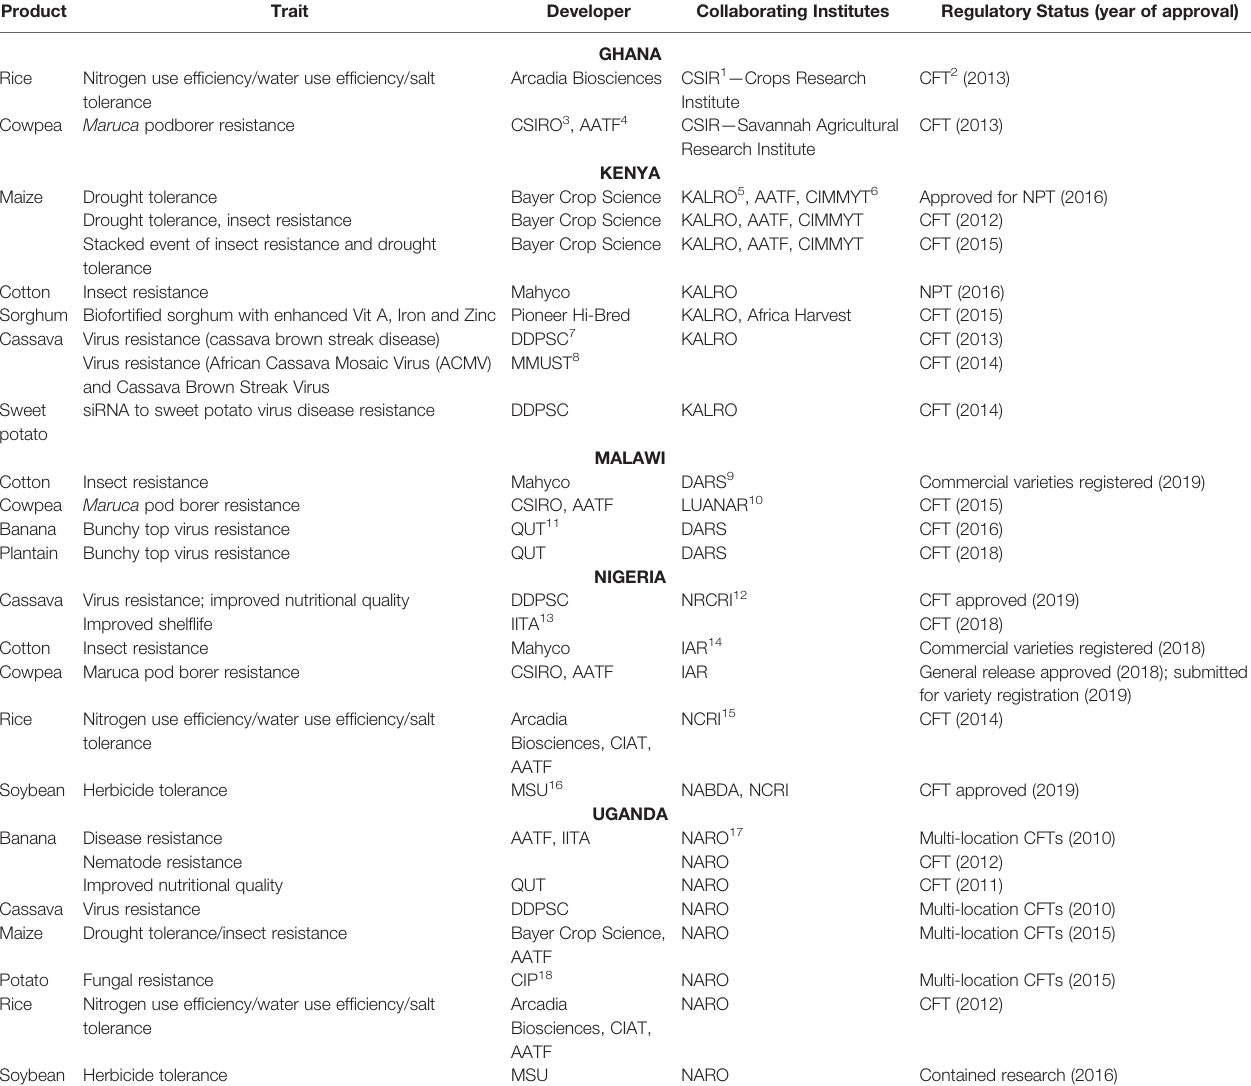
TABLE 1 | Biotechnology crop pipeline in Ghana, Malawi, Nigeria and Uganda (active projects,